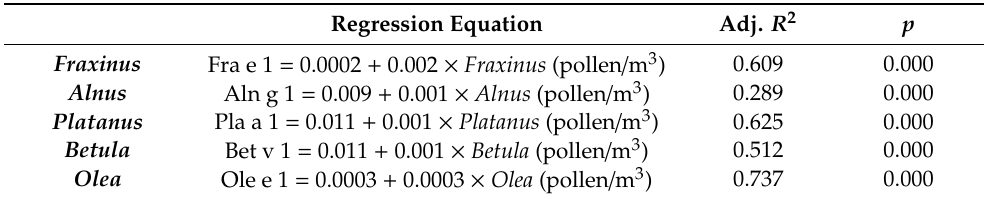
Table 3. Regression equations developed between the pollen concentrations (pollen/m 3 ) and allergen values (ng/m 3 ) during the main pollen season of the assessed taxa.